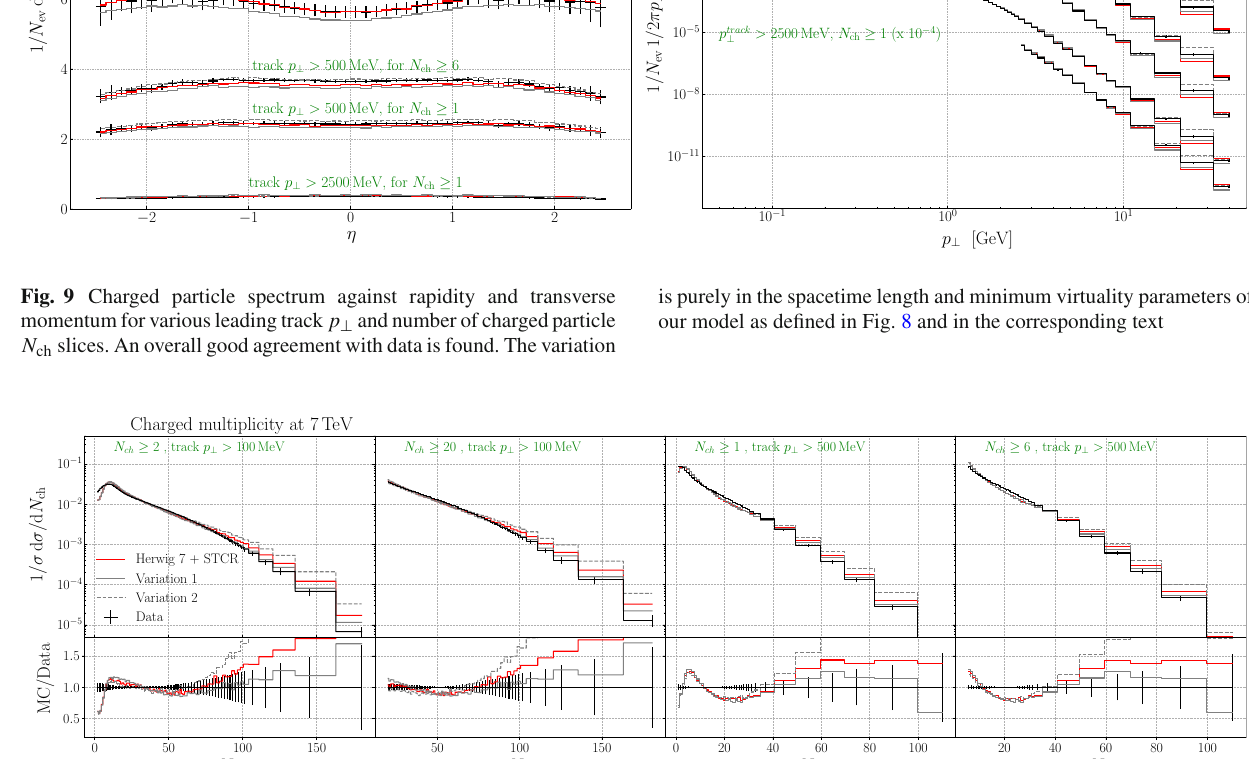
Fig. 10 Differential cross-section with respect to the number of charged particles as measured by